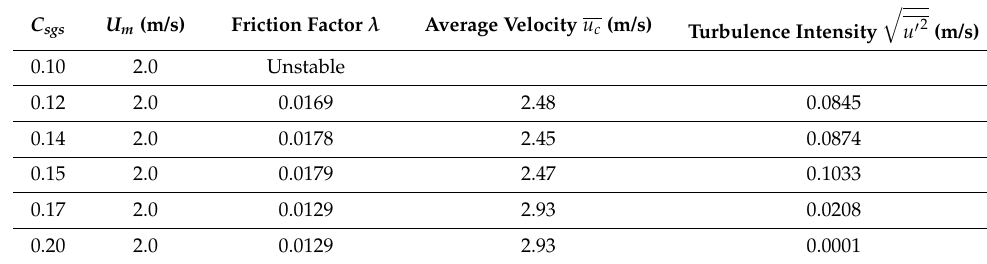
Table 3. The results of this study on C sgs